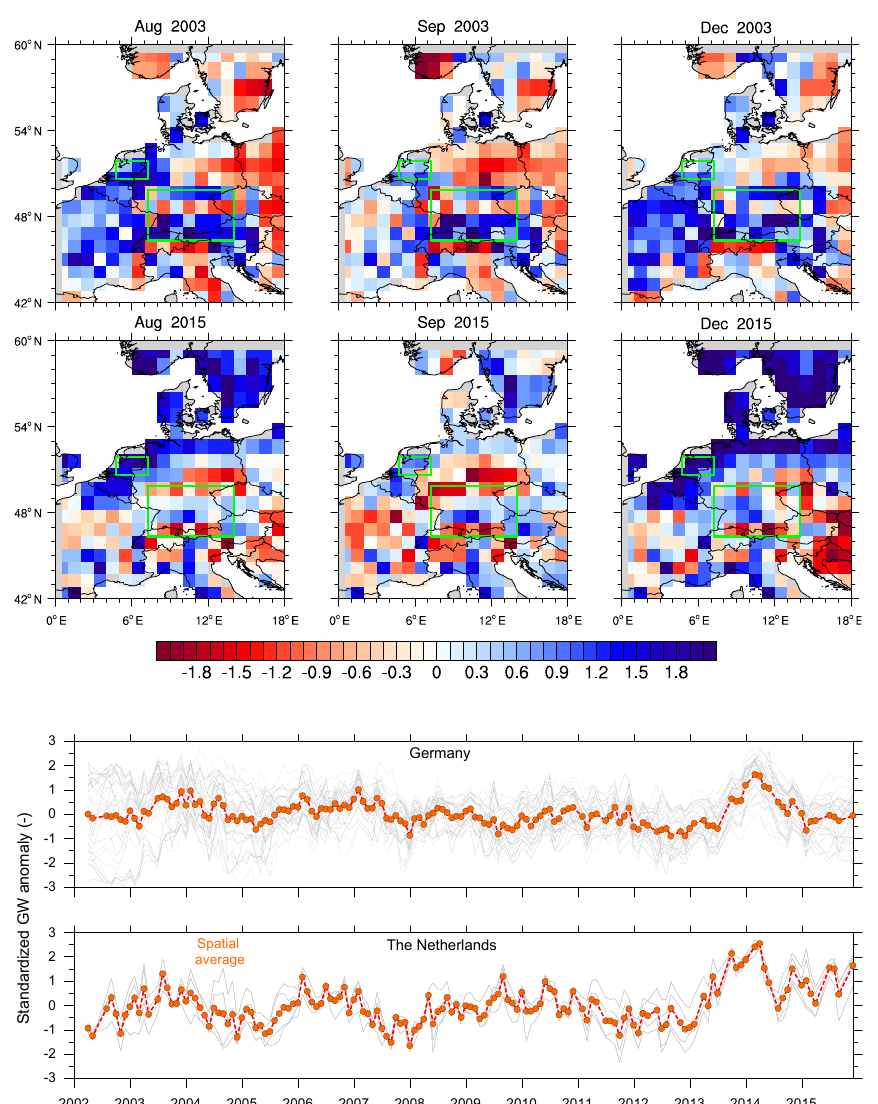
Figure 9. Same as Fig. 8 but after standardisation of the GRACE-GLDAS groundwater anomalies to de-emphasise the seasonality component of the